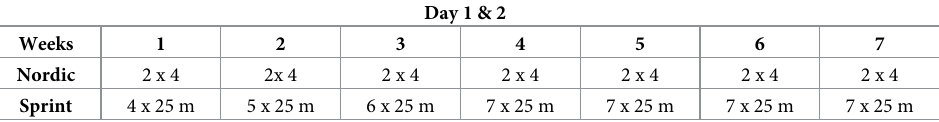
Table 2. Additional training performed by the NHE or sprint intervention groups across the seven-week training intervention, including sets x